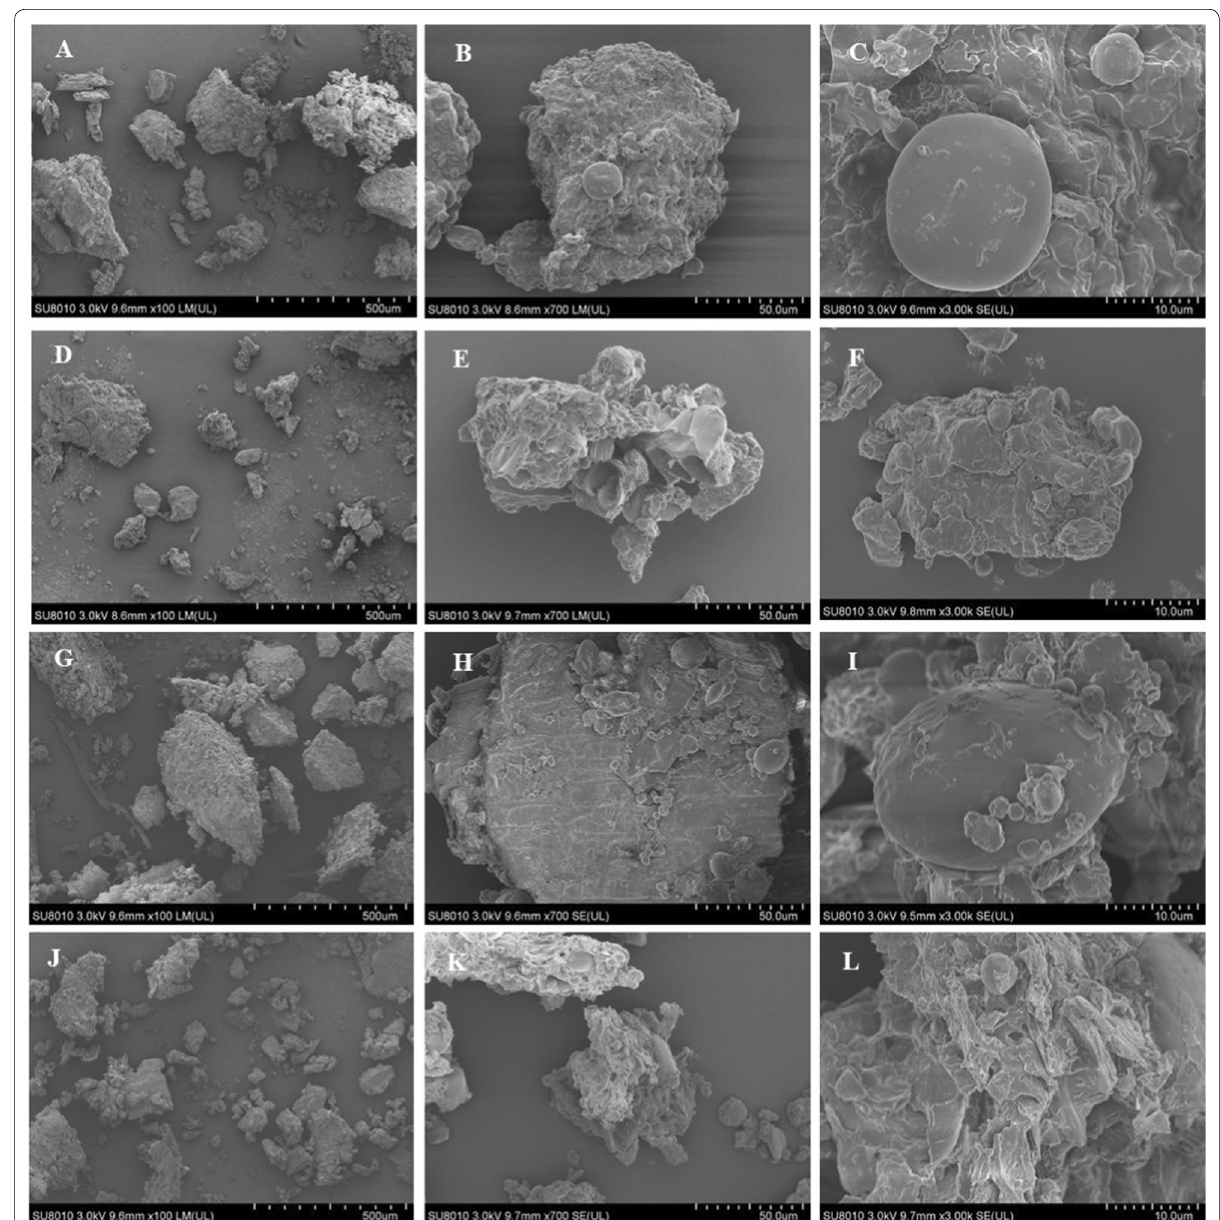
Fig. 2 Scanning electron microscope images ( H , and I ) and FRDDGS ( J , K , and L ),